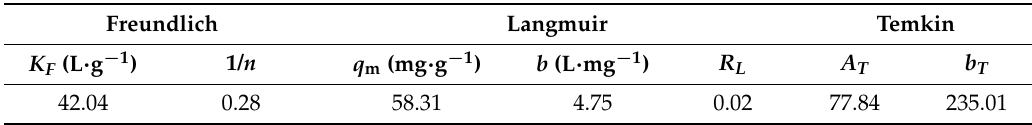
Table 6. Parameter values for the different linear models.